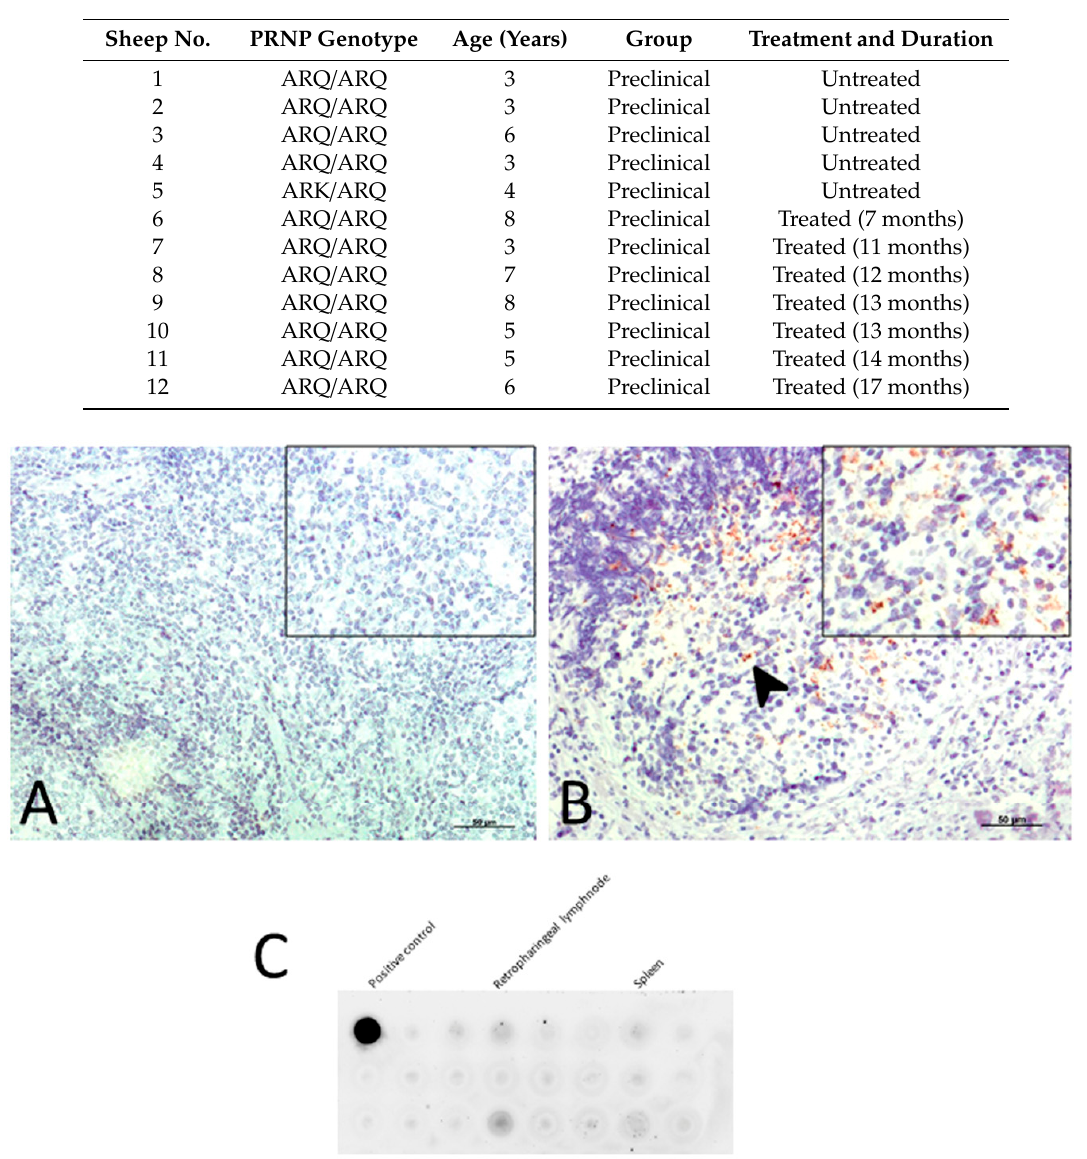
Figure 5. In vivo diagnosis: ( A ) using IHC for PrP sc on biopsies of recto-anal mucosa associated lymphoid tissue (RAMALT) from healthy controls; and ( B ) from sheep presenting no clinical signs but PrP sc deposits (arrow; preclinical stage of scrapie). Scale bars: 50 µm. ( C ) By Dot Blot on a positive retropharyngeal lymph node (product of amplification by Protein Misfolding Cyclic Amplification, PMCA).